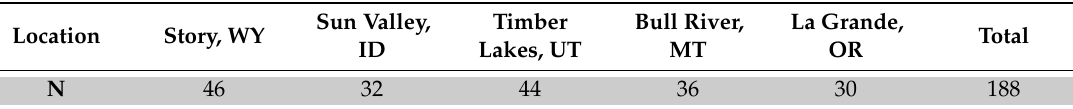
Table 2. Focus group participants by